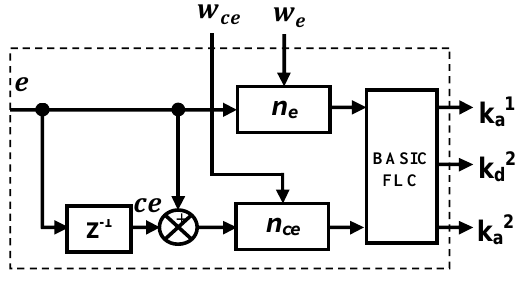
Fig. 4. Structure of Self-Tuning FLC